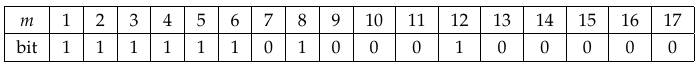
Figure 3. A binary tree example for LOUDs. The one on the left shows the values of the nodes and the one on the right shows the same tree with the numbering of the nodes in a left-to-right order. In this case the numbering starts with 1 at the root.